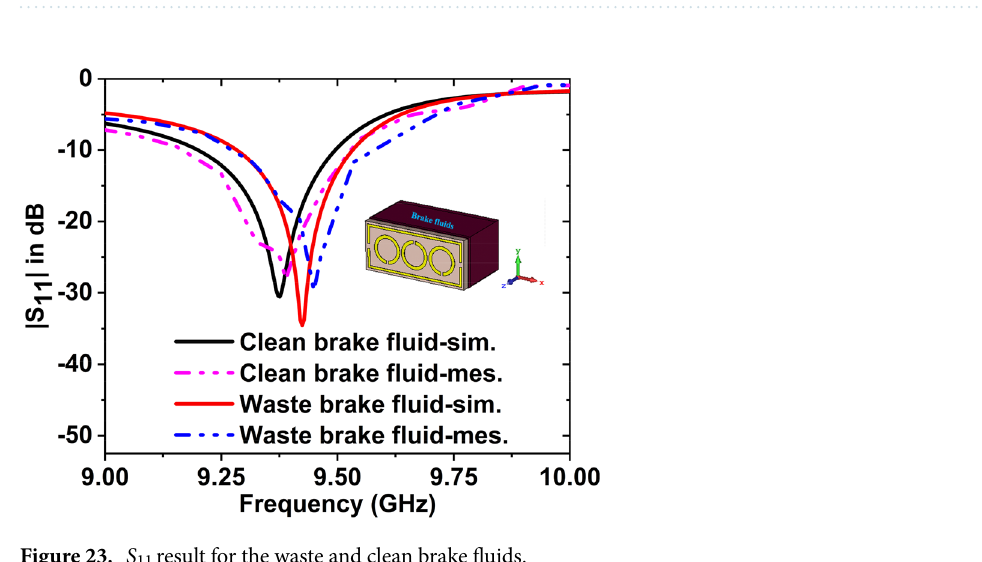
Figure 22. Experimental data of ( a ) DK and ( b ) LT for the waste & clean brake fluids.